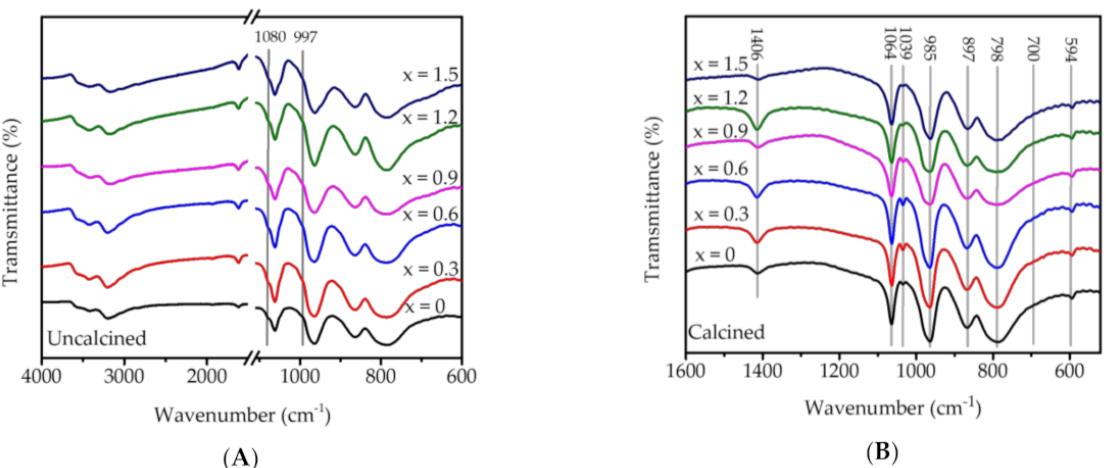
Figure 2. FT-IR spectra of ( A ) uncalcined and ( B ) calcined samples with different x